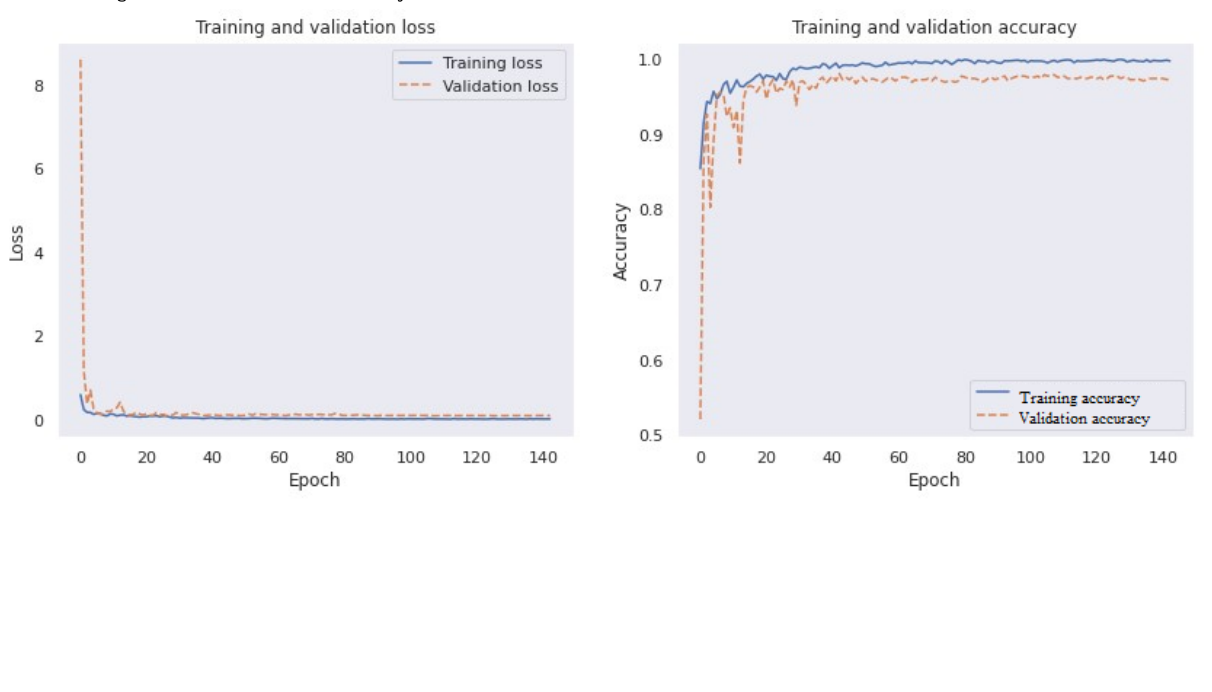
Figure 7. Training and validation loss and